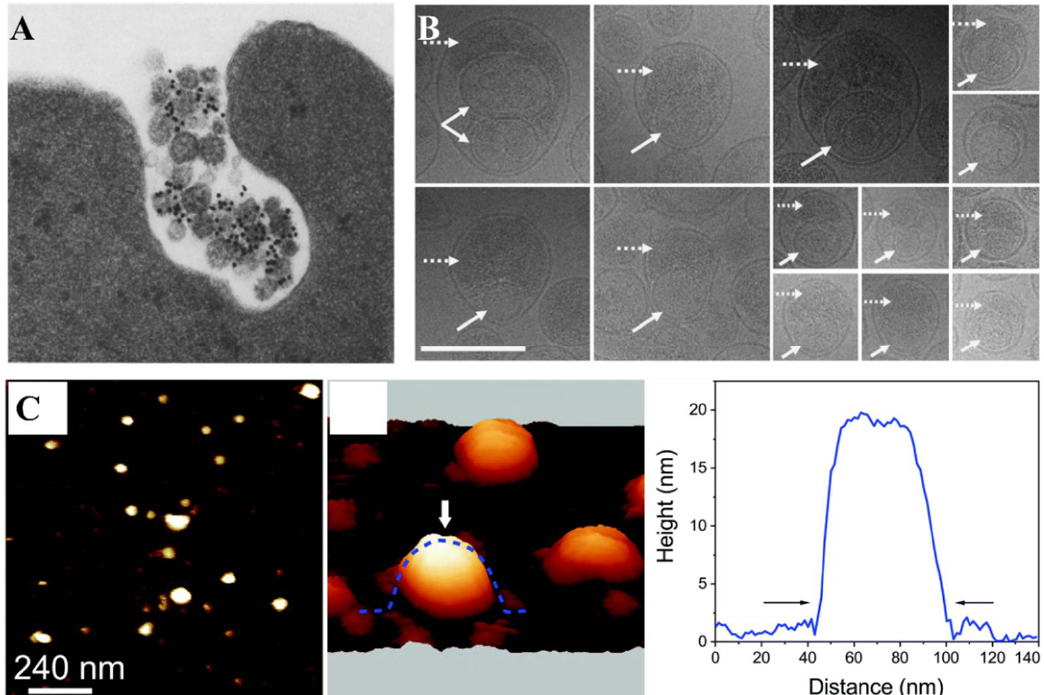
Figure 1. Electron microscopy-based methods for the single EV morphology characterization. ( A ) TEM image of small dense bodies labeled with gold nanoparticles released from multivesicular elements. Reprinted with permission from [40]. Copyright 1985, Rockefeller University Press. ( B ) Morphological characteristics of exosome-like vesicles observed by cryo-EM. Dashed white arrows are showing dark depositions, solid white arrows are showing secondary vesicles. Reprinted with permission from [42]. Copyright 2008, Wiley-Liss, Inc. ( C ) A 3D-force map of exosomes showing round-shaped objects. An exosome marked by a white arrow was used for the force mapping analysis. The exosome samples were isolated by ultracentrifugation. Reprinted with permission from [43]. Copyright 2018, Royal Society of Chemistry.